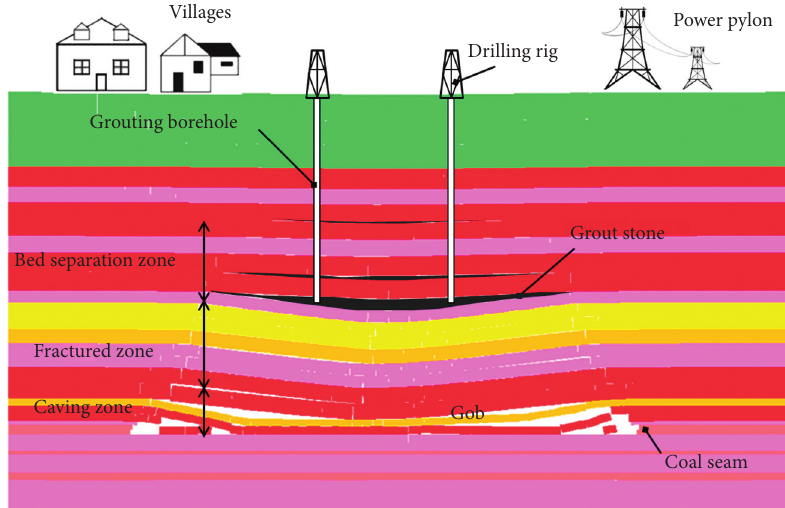
Figure 2: Schematic of the BSBG technique to mitigate the surface